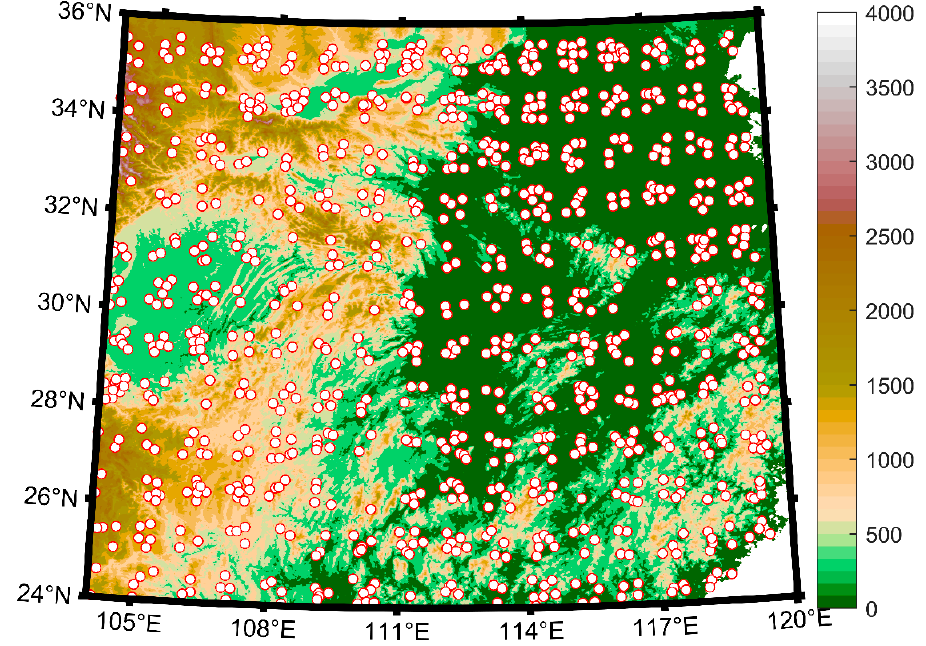
Figure 1. The terrain condition of South China (shading; m). The white dots mark the stations whose MCI data are used in this study. The MCI corresponding to different drought levels is shown in Table